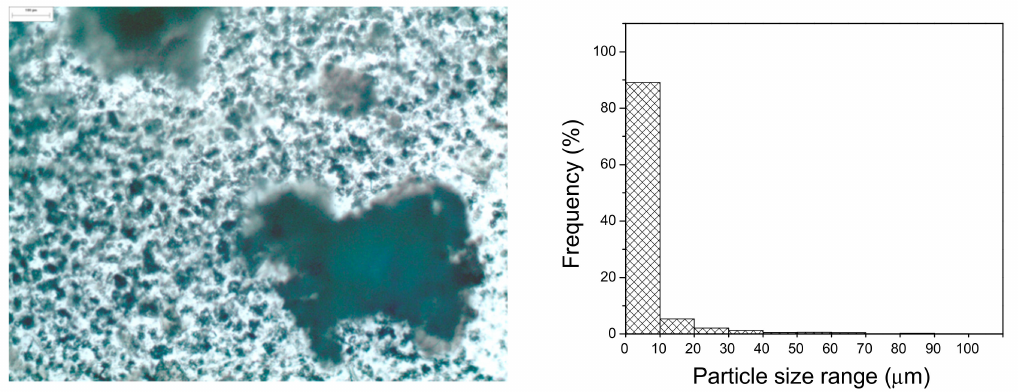
Figure A2. Particle size distribution for GOD / CAT combi-CLEAs ( right ). The particle diameter was obtained from microscopy images (Olympus BX60 microscope, Olympus Co., Tokyo, Japan) of combi-CLEAs ( left ) using the Image-Pro ® Plus software (Version 7.0 for Windows, Media Cybernetics, Inc., Bethesda, MD, USA), where the frequency count was performed using a step size of 10 µ